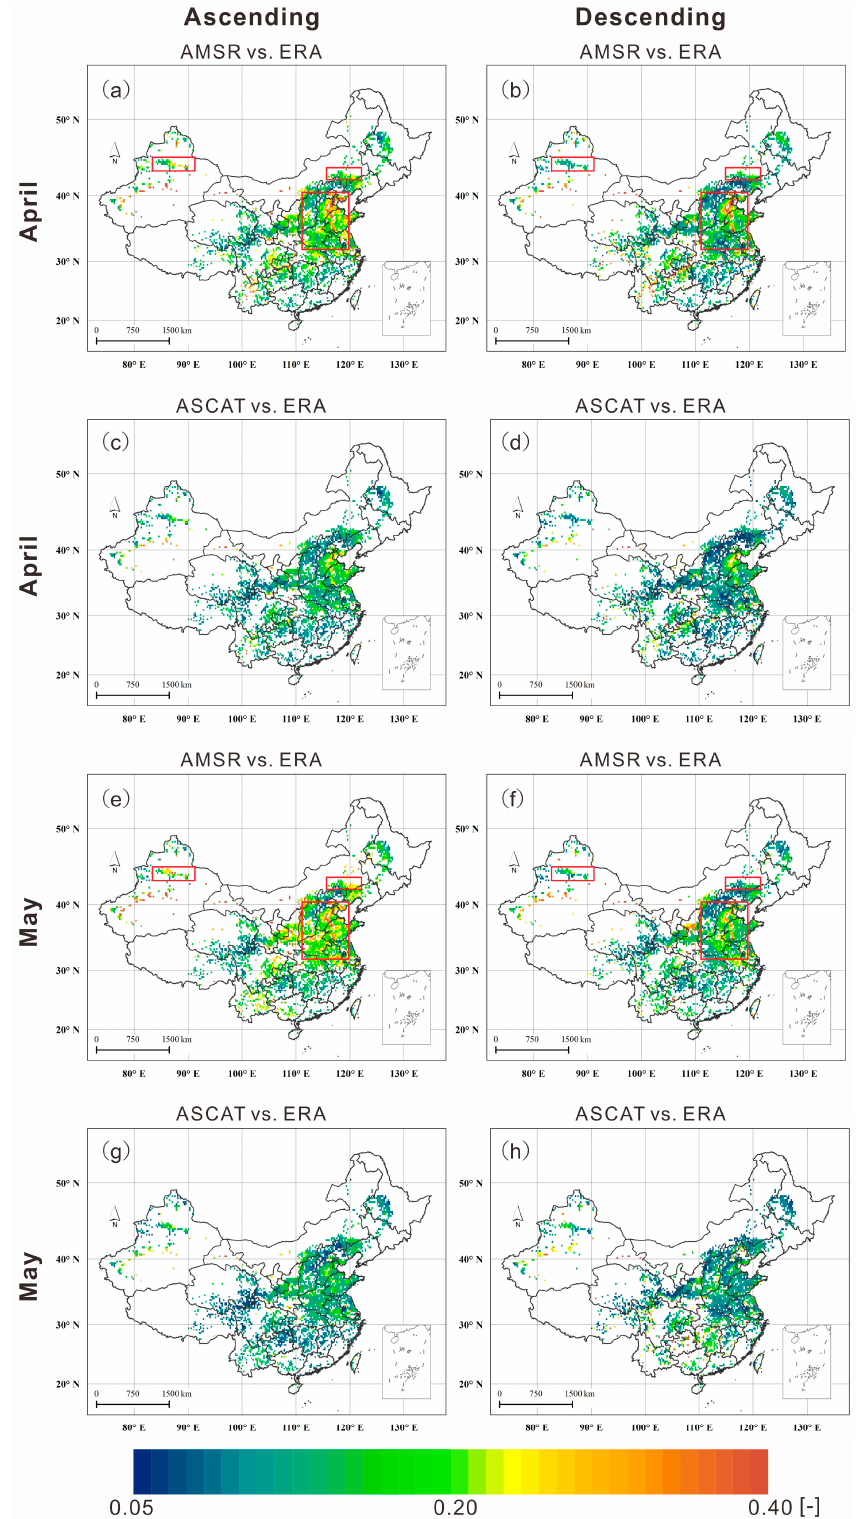
Figure 9. K-S metrics comparison of the differences in soil moisture distributions from microwave soil moisture retrievals and ERA-Interim: the left column is for ascending orbits of AMSR vs. ERA pair and ASCAT vs. ERA pair; the right column is for descending orbits of the same pairs. Results from April are shown in the first two rows, while results from May are shown in the last two rows.